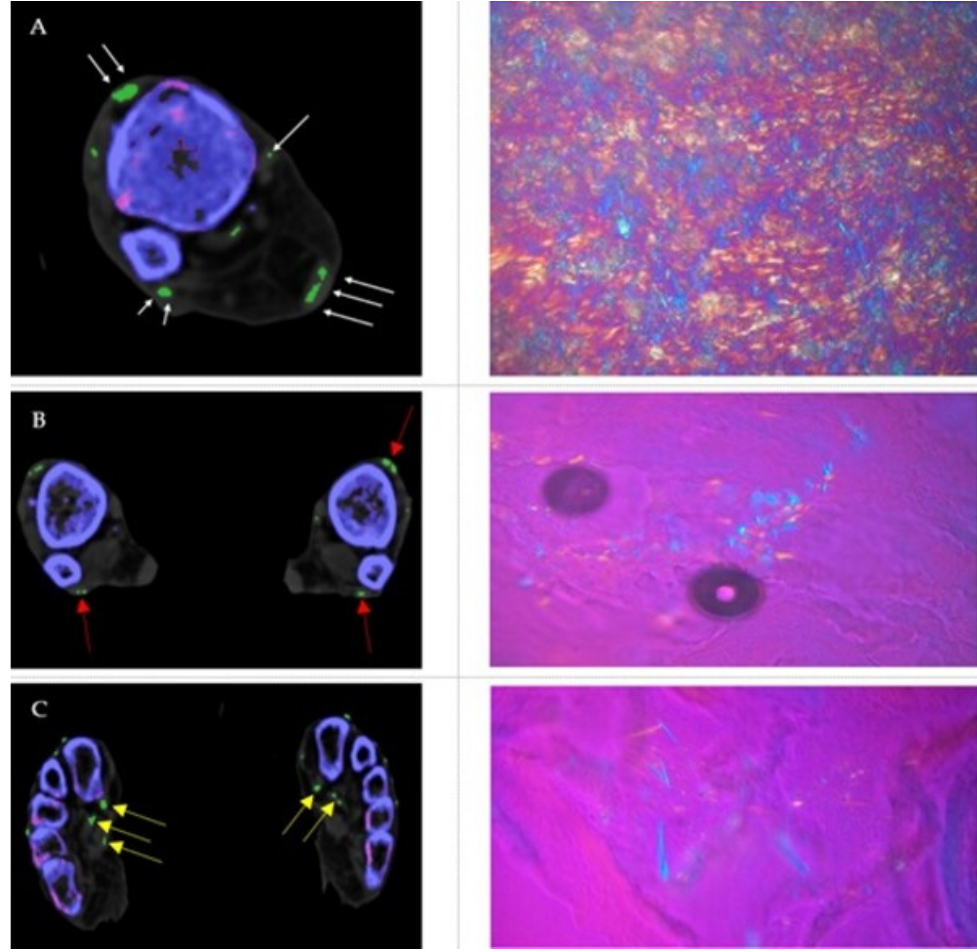
Figure 3. ( A ) Axial DECT image showing MSU deposits within the TAT, PT, AT, and TPT (white arrows) with corresponding microscopic image taken from the AT, showing large diffuse packed and patchy MSU crystals with strong negative birefringence (bluish structures). ( B ) Axial DECT image demonstrating MSU deposits within the TAT and PT (red arrows) with corresponding microscopic image taken from the PT. ( C ) Axial DECT image showing MSU deposits within the FHL and flexor digitorum longum tendon (yellow arrows) with corresponding microscopic image taken from the FHL.